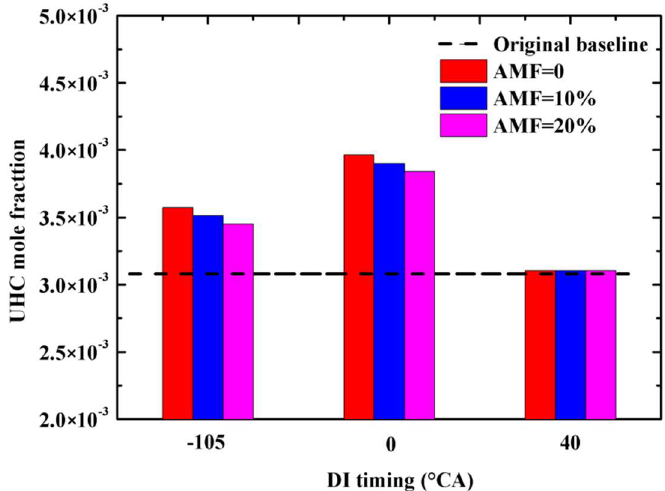
Figure 12. UHC variation at different DI timings and AMF values.